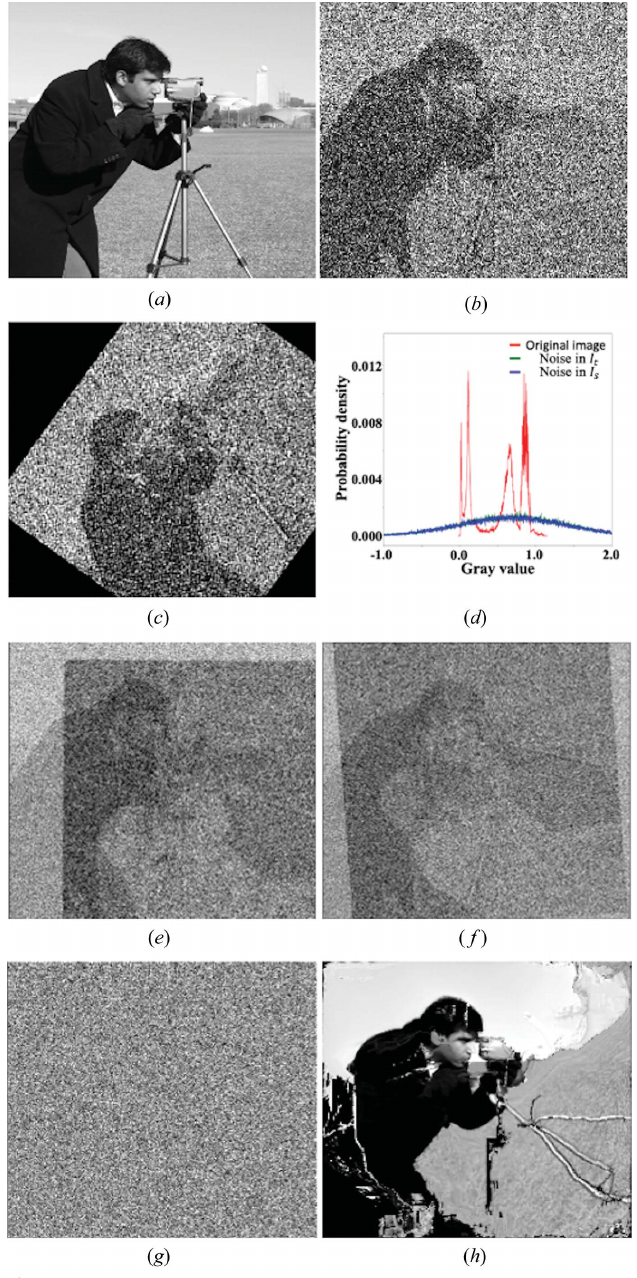
Figure 3 Images used in experiment 1 and results. ( a ) Original image. Panels ( b ) and ( c ) show the synthesized target and source images with additive noises. ( d ) Histograms of ( a ) and additive noises in ( b ) and ( c ). ( e )–( g ) Difference images between ( b ) and the registered images with FPC, SSD and TVDM. The edge features in ( e ) and ( f ) indicate that the images are not registered correctly. ( h ) Registered image with OFTV; local distortions in the registered image are